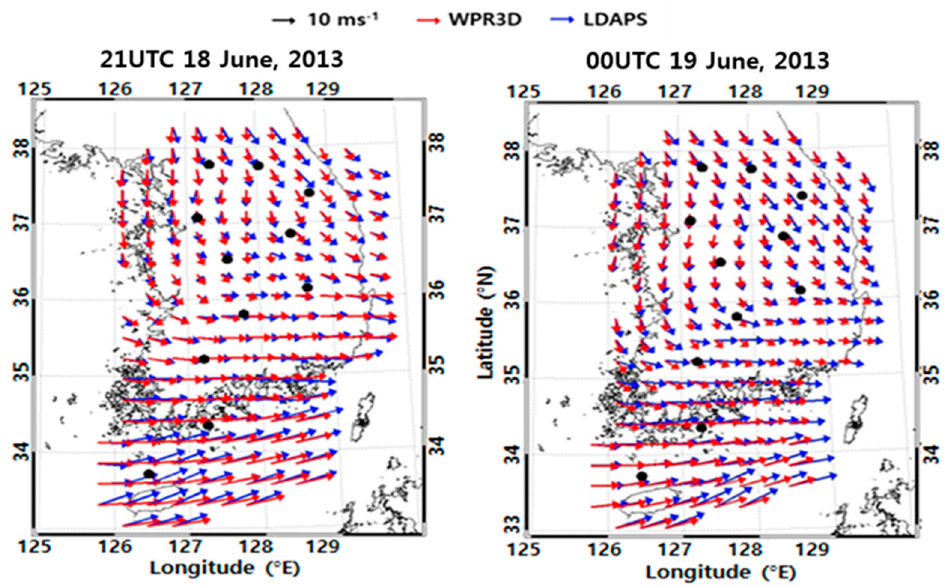
Figure 16. Comparison of the horizontal wind fields between the M-WPR3D (red arrow) and the LDAPS (blue arrow) at an altitude of 1.5 km.